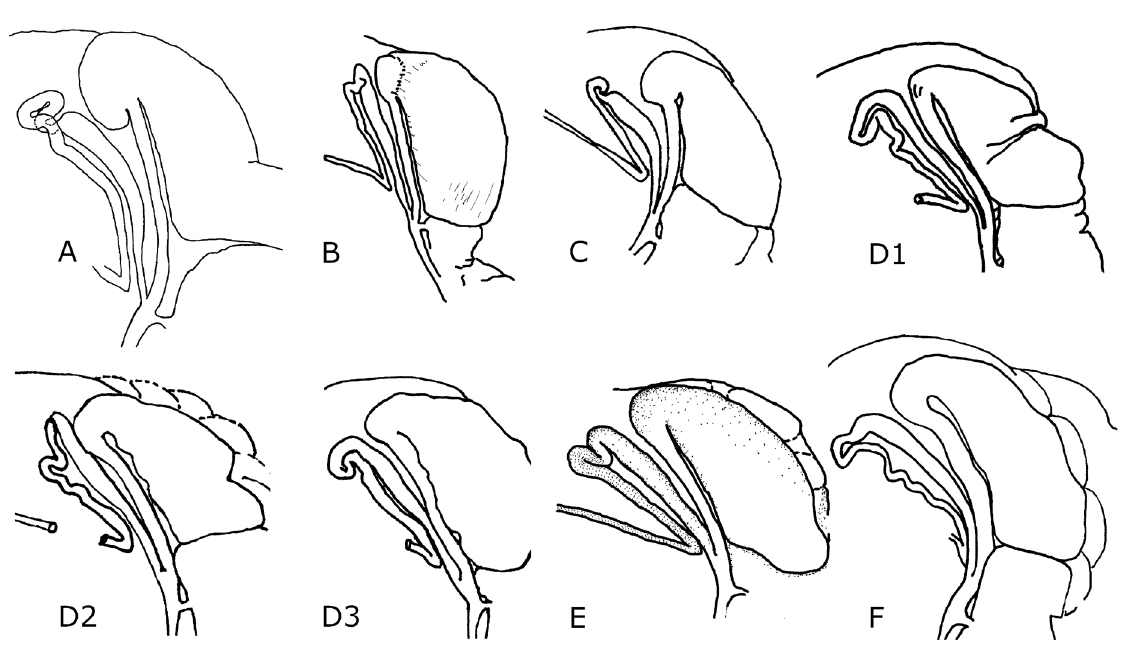
Fig 26. Variation of the female genitalia in Cochlostoma ( Clessiniella ) stelucarum sp. nov. A . Mt Valinis, Italy (EZ0096). B . Campone, Italy (EZ0098). C . Anduins, Italy (EZ0102). D1–D3 . Cornino, Italy (EZ0104). E . Cjanet-Peonis, Italy (EZ0105). F . Mt Bernadia, Italy